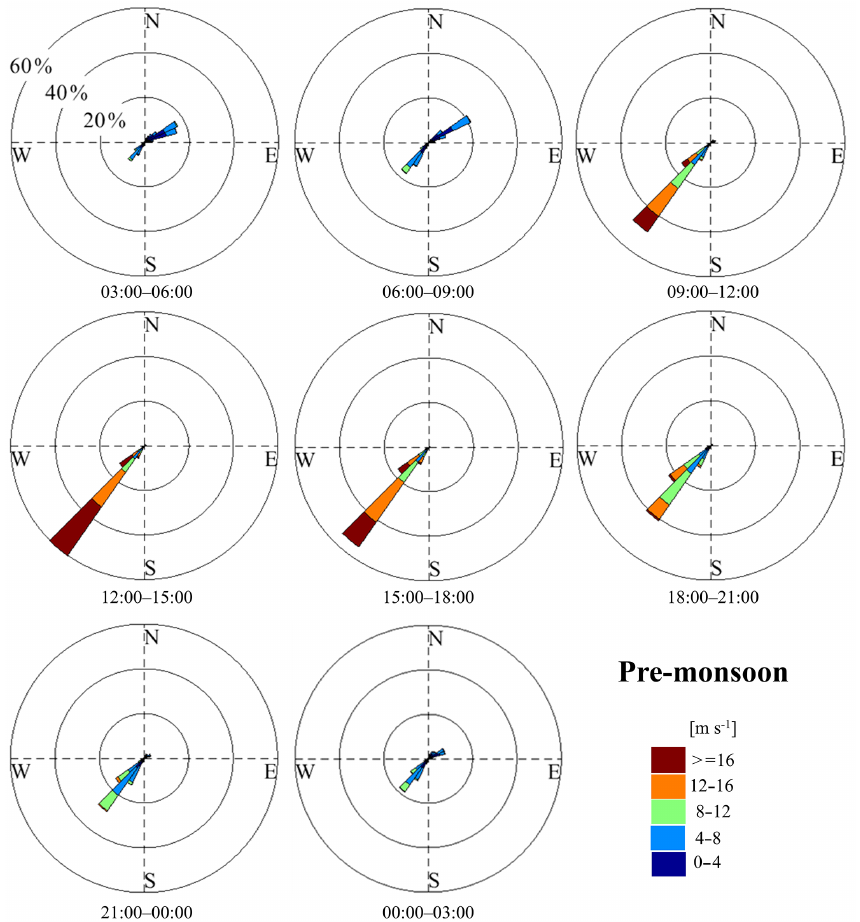
Figure 3. Wind rose for pre-monsoon season – binned into 3h increments depiciting diurnal evolution in wind speed and direction at